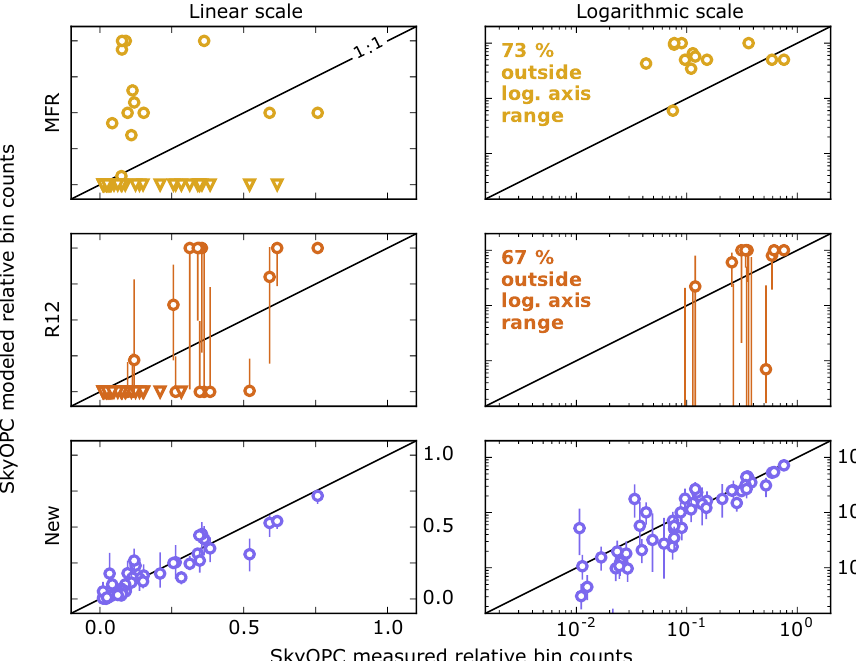
Figure 6. Scatter plots of all modeled relative SkyOPC bin counts for the PSL standards versus their measured counterparts for the three different approaches (rows). The comparisons are shown on linear and logarithmic scales on the left- and right-hand side respectively. The markers represent the model best estimates and the error bars are the range between the 16 and 84th percentiles of the corresponding PDFs. The black lines follow the one-to-one relationship. Significant model underestimations, i.e., vanishingly small model values where non- vanishing bin counts are measured, occur in the two upper rows. The number fraction of significantly underestimated values is noted in the upper left corner of the logarithmic scale plots and the corresponding values are shown with triangular markers in the linear scale